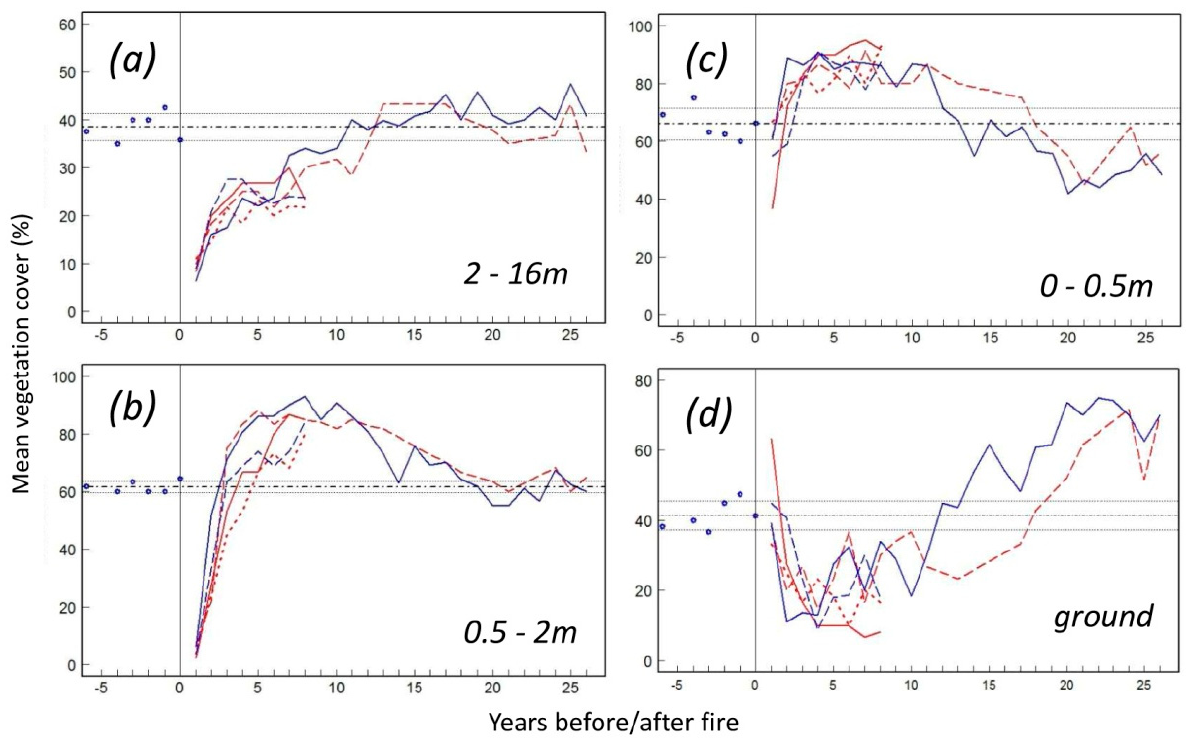
Figure 5. Postfire variation of the vegetation cover within three layers summarizing the 8-layer profile; x -axis: years since the last fire; y -axis: estimated cover (in %). ( a ) Maximum cover within the layers 2–4 m, 4–8 m and 8–16 m. ( b ) Maximum cover within the layers 0.5–1 m and 1–2 m. ( c ) Maximum cover within the layers 0–0.25 m and 0.25–0.5 m. ( d ) Open ground (rock cover). Graphic conventions: see Figure 2. Table 1. Average vegetation profiles by layer (percentages averaged over six consecutive years)